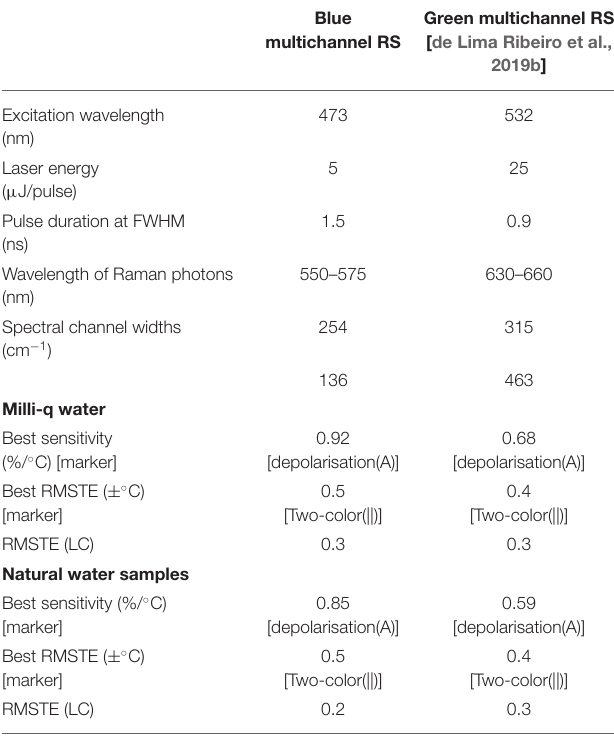
TABLE 4 | Technical overview of two multichannel LIDAR-compatible RS integrated to 473nm (blue) and 532nm (green) excitation lasers.